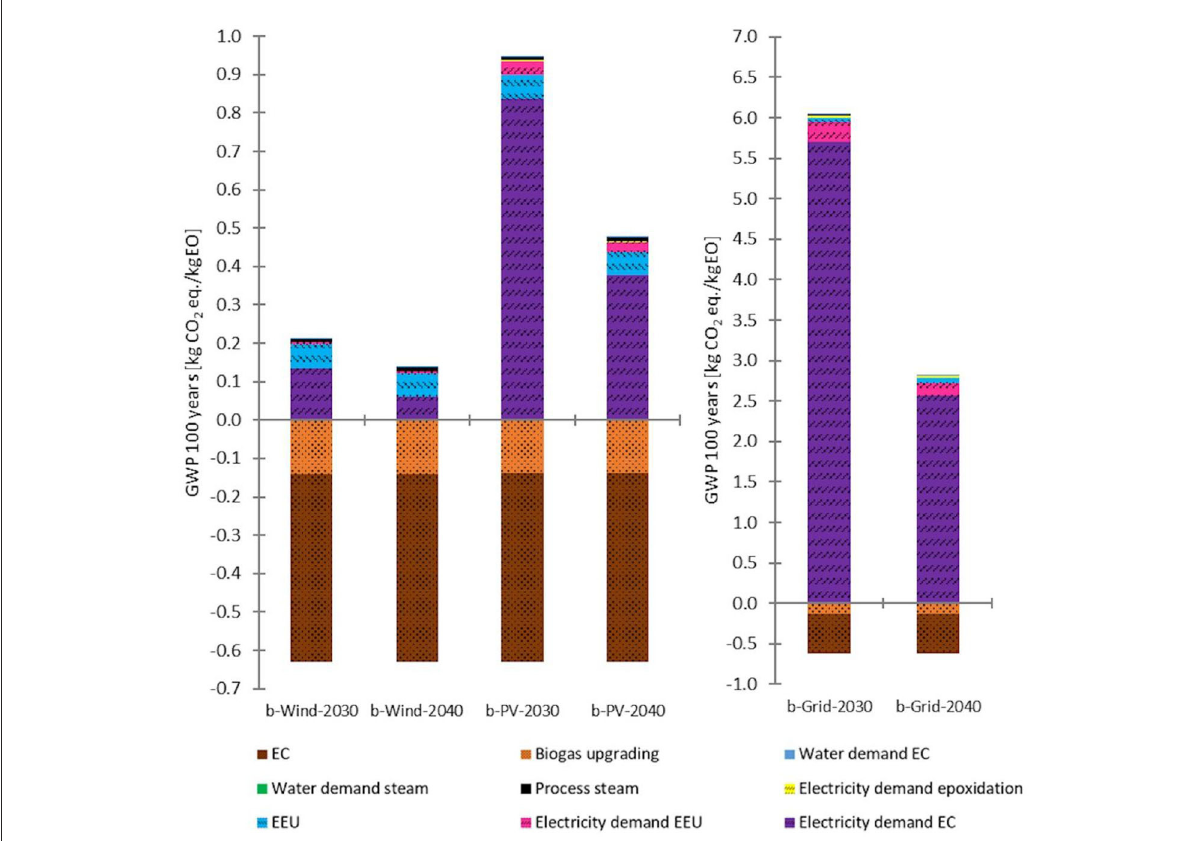
FIGURE7 Detailed GWP 100 years of 2030 and 2040 biogenic CO 2 (short: b) scenarios with different energy supplies. Left: wind and PV power scenarios. Right: grid-mix scenarios. Source: own data and